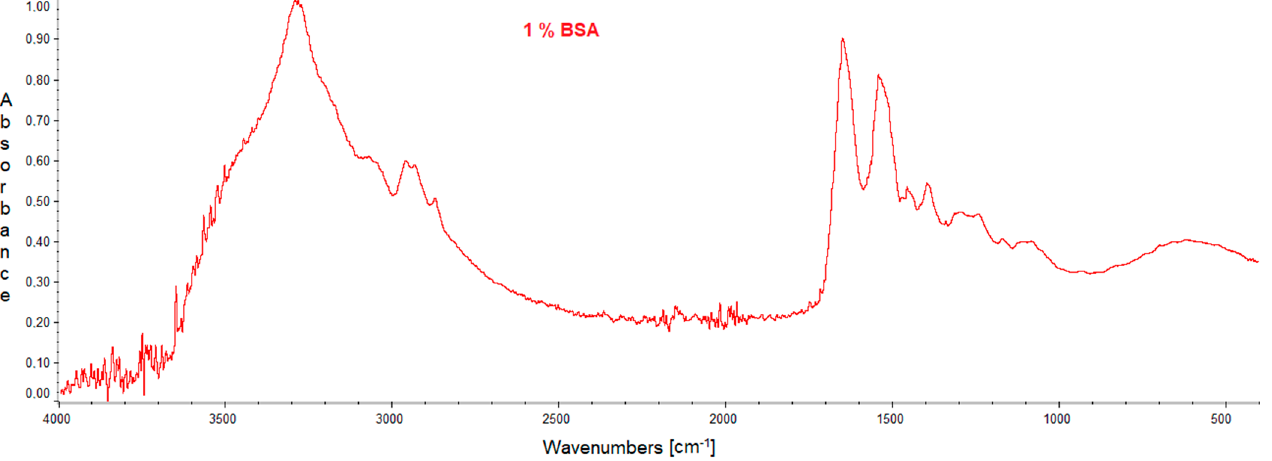
Figure 2. IR spectrum of the film obtained from 1% solution of BSA.